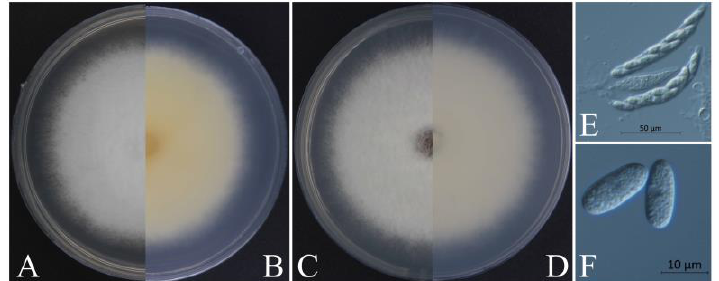
Figure 8. Morphological characteristics of Colletotrichum aenigma. ( A , B ) Front and reverse views of 4-day-old fungus on PDA of C. aenigma (2022), respectively. ( C , D ) Front and reverse views of 4-day-old fungus on SNA of C. aenigma (2020), respectively. ( E ) Asci of C. aenigma (2020), scale bar = 50 μm. ( F ) Ascospores of C. aenigma (2020), scale bar = 10 μm.